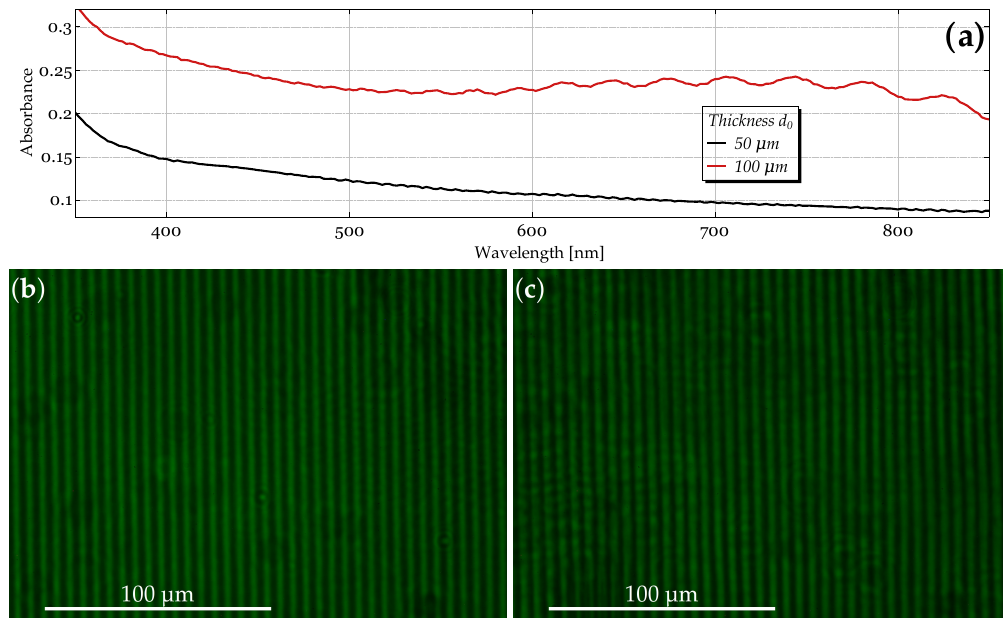
Figure 3. Characterization of the samples’ optical quality for d 0 = 50 and 100 µ m. ( a ) Absorbance as a function of wavelength in the UV-Vis range. The data include contributions from reflection (independent of d 0 ), absorption and scattering losses. The morphology of the gratings visualized by polarization optical microscope (POM) ( λ = 546 nm) for ( b ) d 0 = 50 and ( c ) 100 µ m,